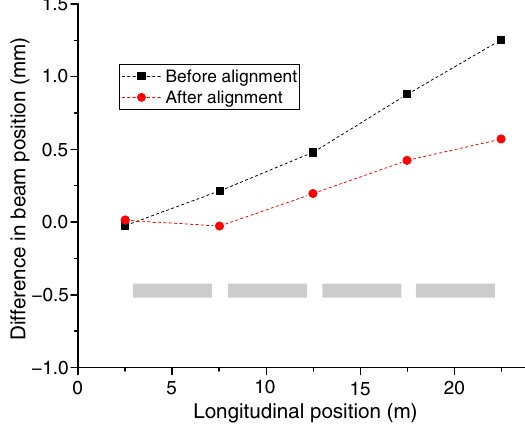
FIG. 54. Measured beam position variation along the injector in the horizontal plane in response to a change in rf gradient, before and after the beam-based alignment of the first booster structure. The beam position at the second BPM immediately after the first S-band structure is almost unchanged after the alignment, whereas further downstream changes persist due to the still misaligned structures. The locations of the four booster structures are indicated as gray boxes.